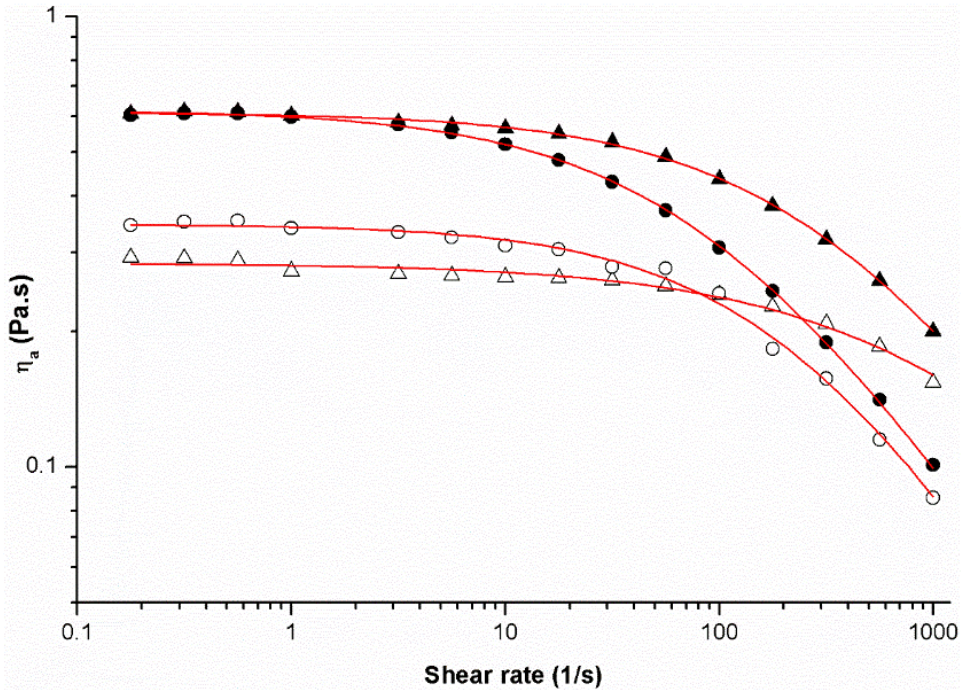
Figure 1. Viscosity flow curves of the emulsions: chitosan (C-OO) (triangular plots) and alginate (A-OO) (circular plots), at temperatures of 4 °C (solid plots) and 25 °C (open plots). Continuous lines represent the predictions of the simplified Cross model.